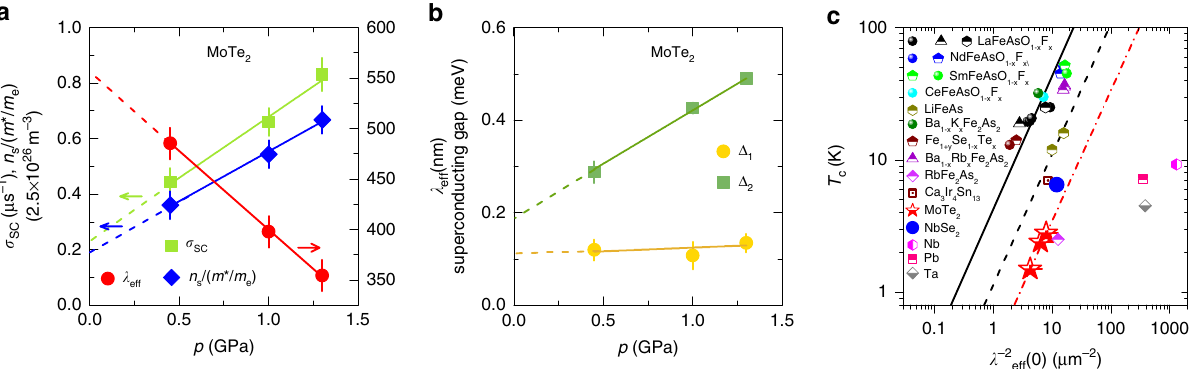
Fig. 5 Pressure evolution of various quantities. The SC muon depolarization rate σ SC , magnetic penetration depth λ eff and the super fl uid density n s / m * m e ( a ) as well as the zero-temperature gap values Δ 1,2 (0) ( b ) are shown as a function of hydrostatic pressure. Dashed lines are guides to the eye and solid lines represent linear fi ts to the data. The error bars represent the s.d. of the fi t parameters. c A plot of T c vs. λ (cid:2) 2 MoTe 2 . The dashed red line represents the linear fi t to the MoTe 2 data. The Uemura plot for various cuprate and Fe-based HTSs is also shown 49,66 – 70 . The relation observed for underdoped cuprates is also shown (solid line for hole doping 55 – 59 and dashed black line for electron doping 61 ). The points for various conventional BCS superconductors and for NbSe 2 are also shown